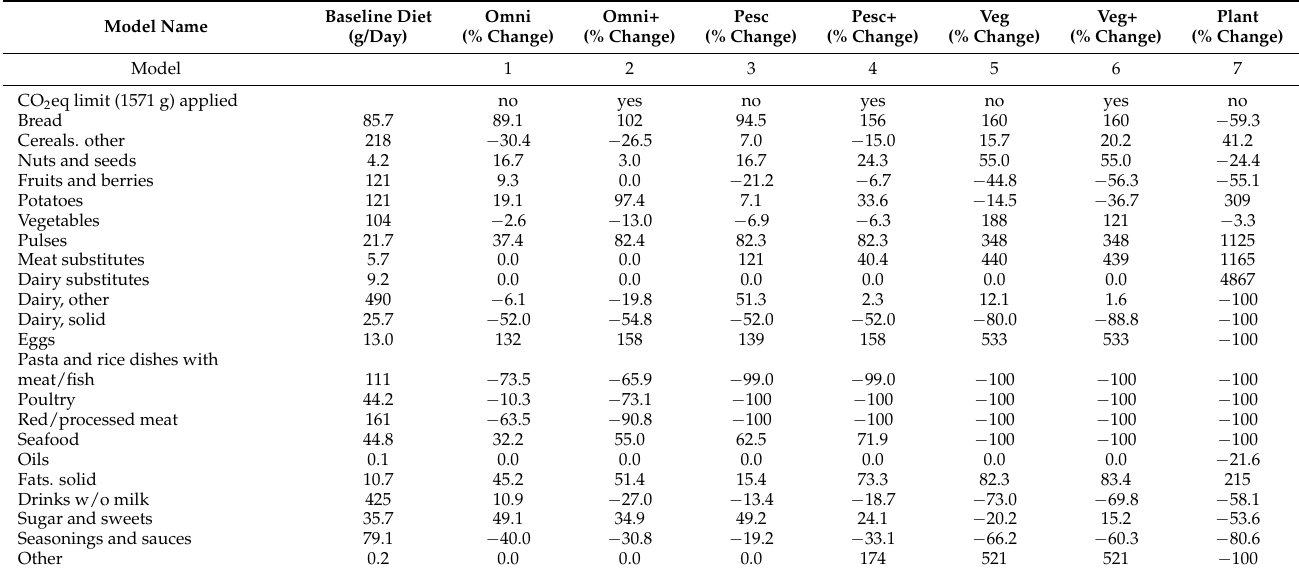
Table 3. Baseline intakes of food groups among Swedish adolescents and relative changes in food groups after optimization of different dietary